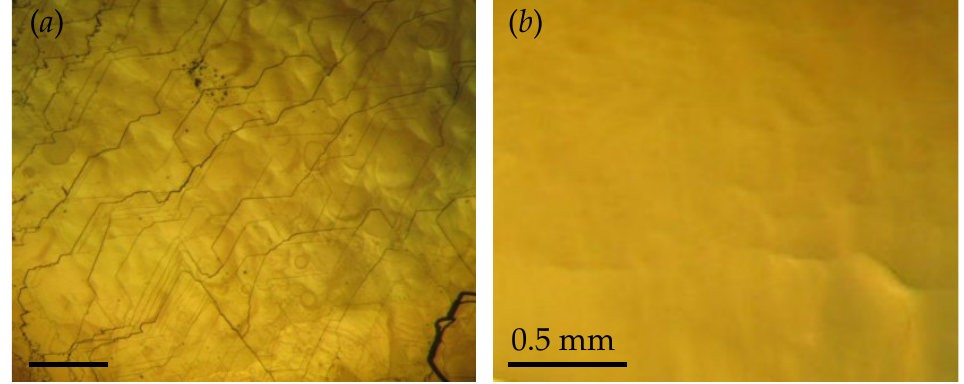
Figure 1. Optical micrographs (in reflected light) of SiC substrate 8 mm in diameter after annealing